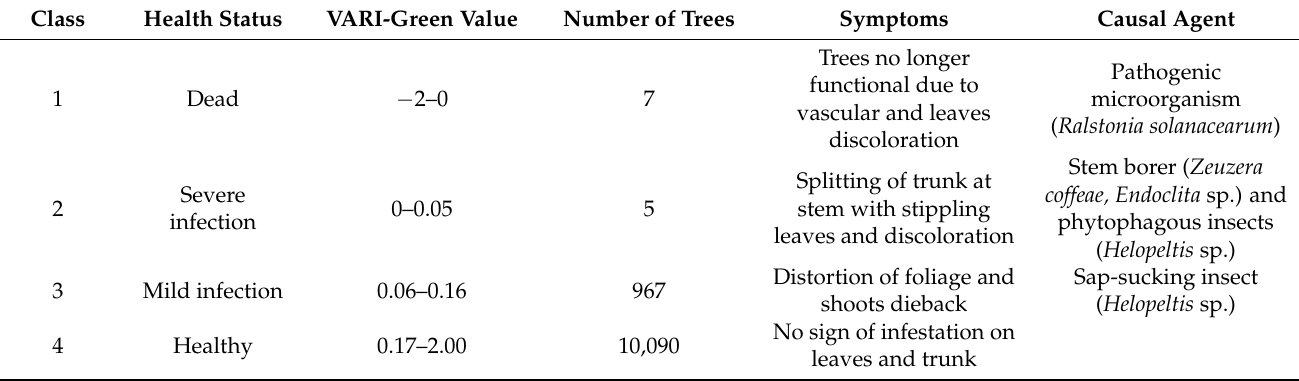
Table 5. Classification of health status base on the percentage of indices value of VARI-green. Class Health Status VARI-Green Value Number of Trees Symptoms Causal Agent